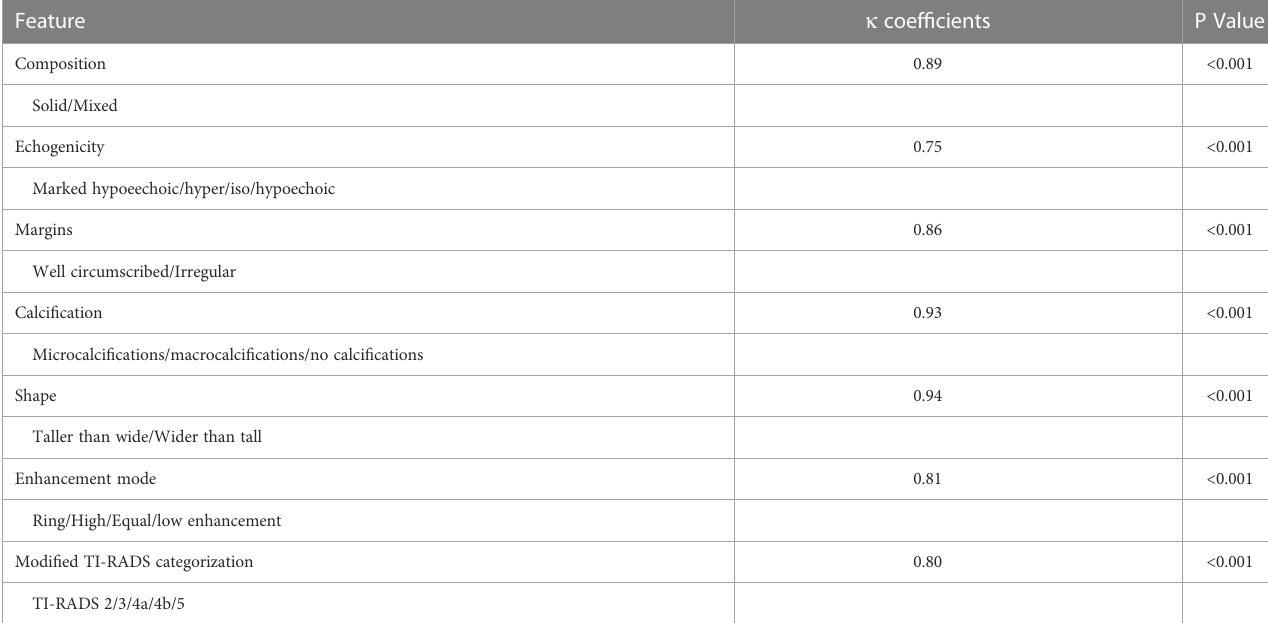
TABLE 4 The inter-observer agreement for US features and TI-RADS categorization for the diagnosis of thyroid nodules. Feature k coef fi cients P